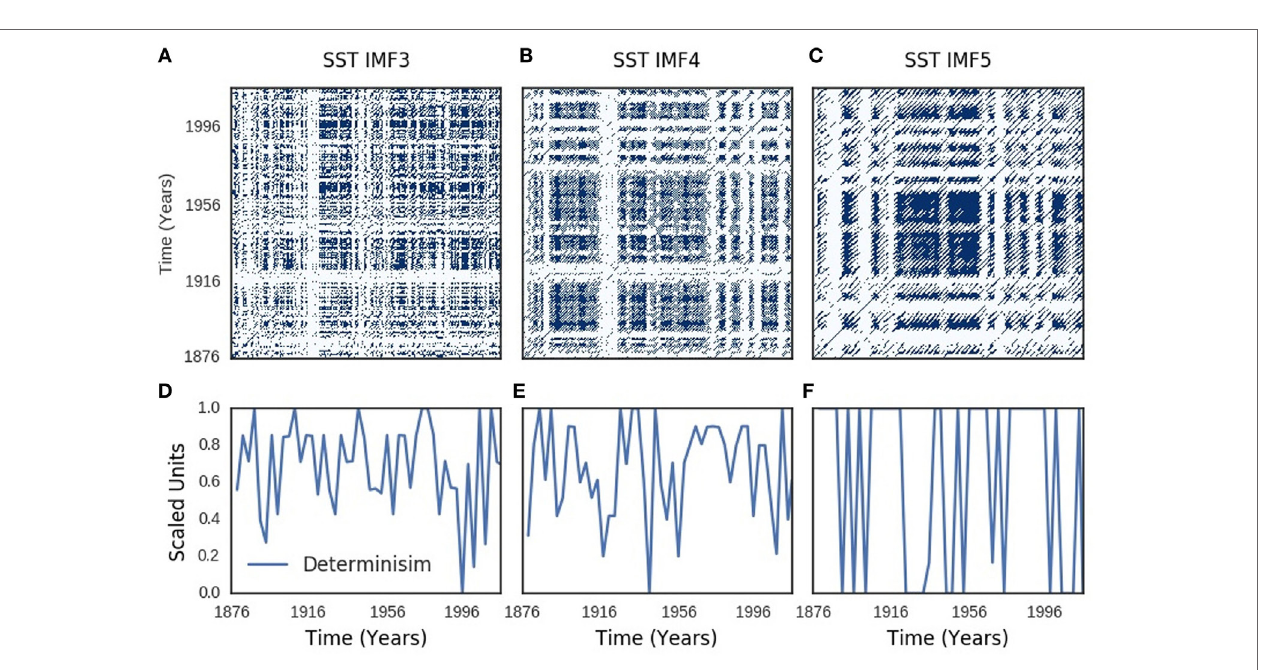
pandemic is shown in Figure 6A . The geometrical mean (range) was 0.6 (0–1) for cross correlation (CPR) index of SOI and SST joint recurrence of annual components ( Figure 6B ).